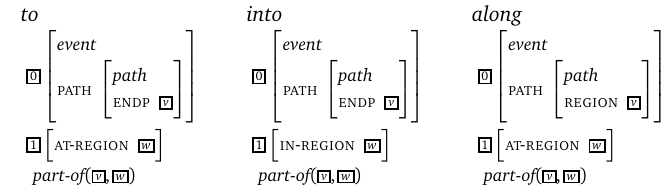
Frame examples for directional